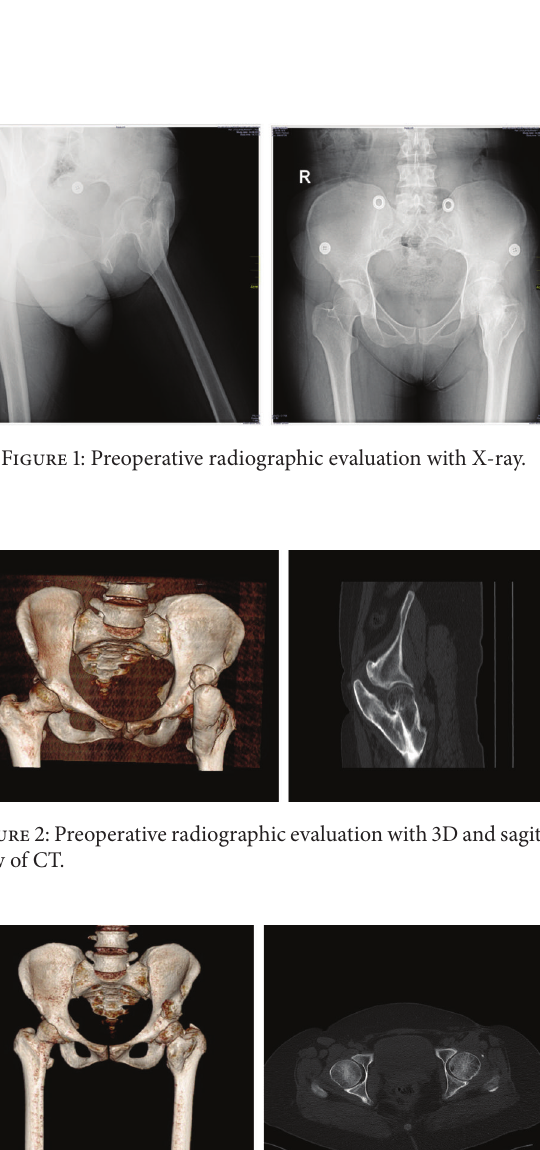
Figure 6: Surgically excised